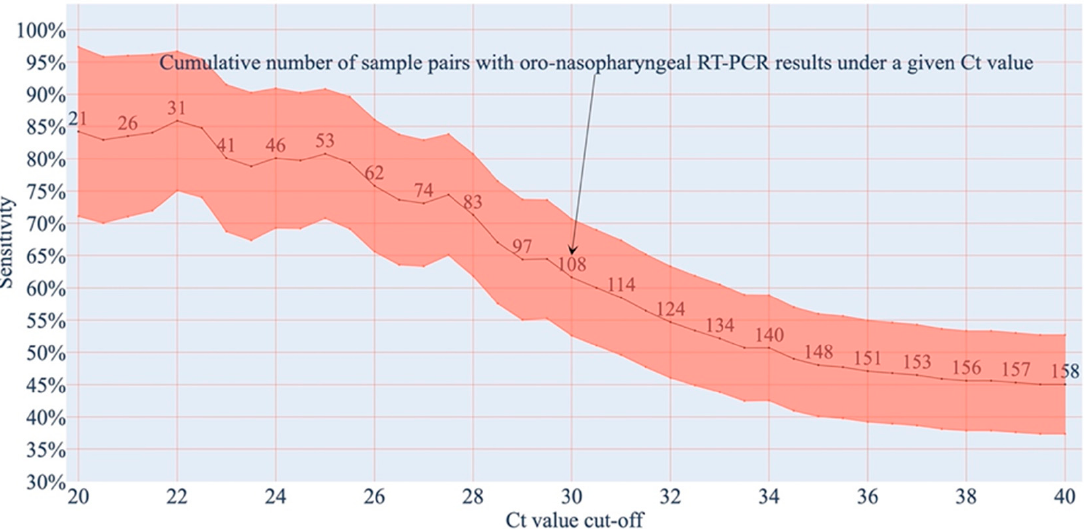
Figure 1. The cumulative sensitivity of LAMP displays a negative correlation with increasing Ct value cut-offs. The cut-offs were applied on the Ct values derived from the RT-PCR of paired oro- nasopharyngeal samples. The orange band presents 95% Wilson score (confidence) intervals for the sensitivities with respect to the given Ct value cut-offs. The black line presents the center values of these intervals. The numbers directly above the black center-value line indicate the number of sample pairs satisfying a given Ct value